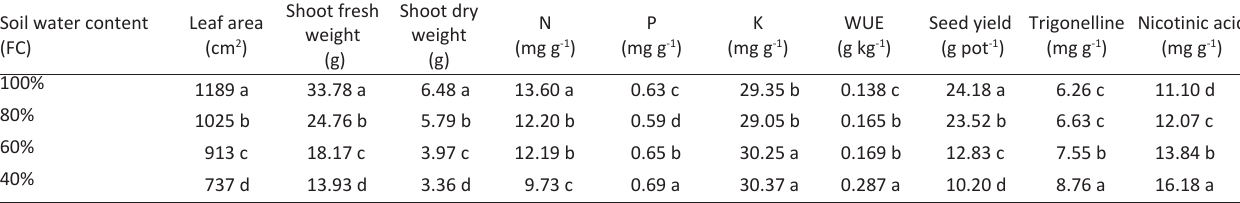
Table 2 - Results of mean comparison of different irrigation treatments Soil water content (fC)